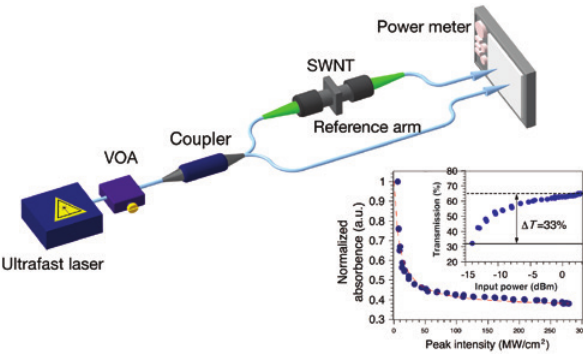
Figure 9: Modulation depth measurement setup. Inset: Normalised absorption and transmission as a function of pump